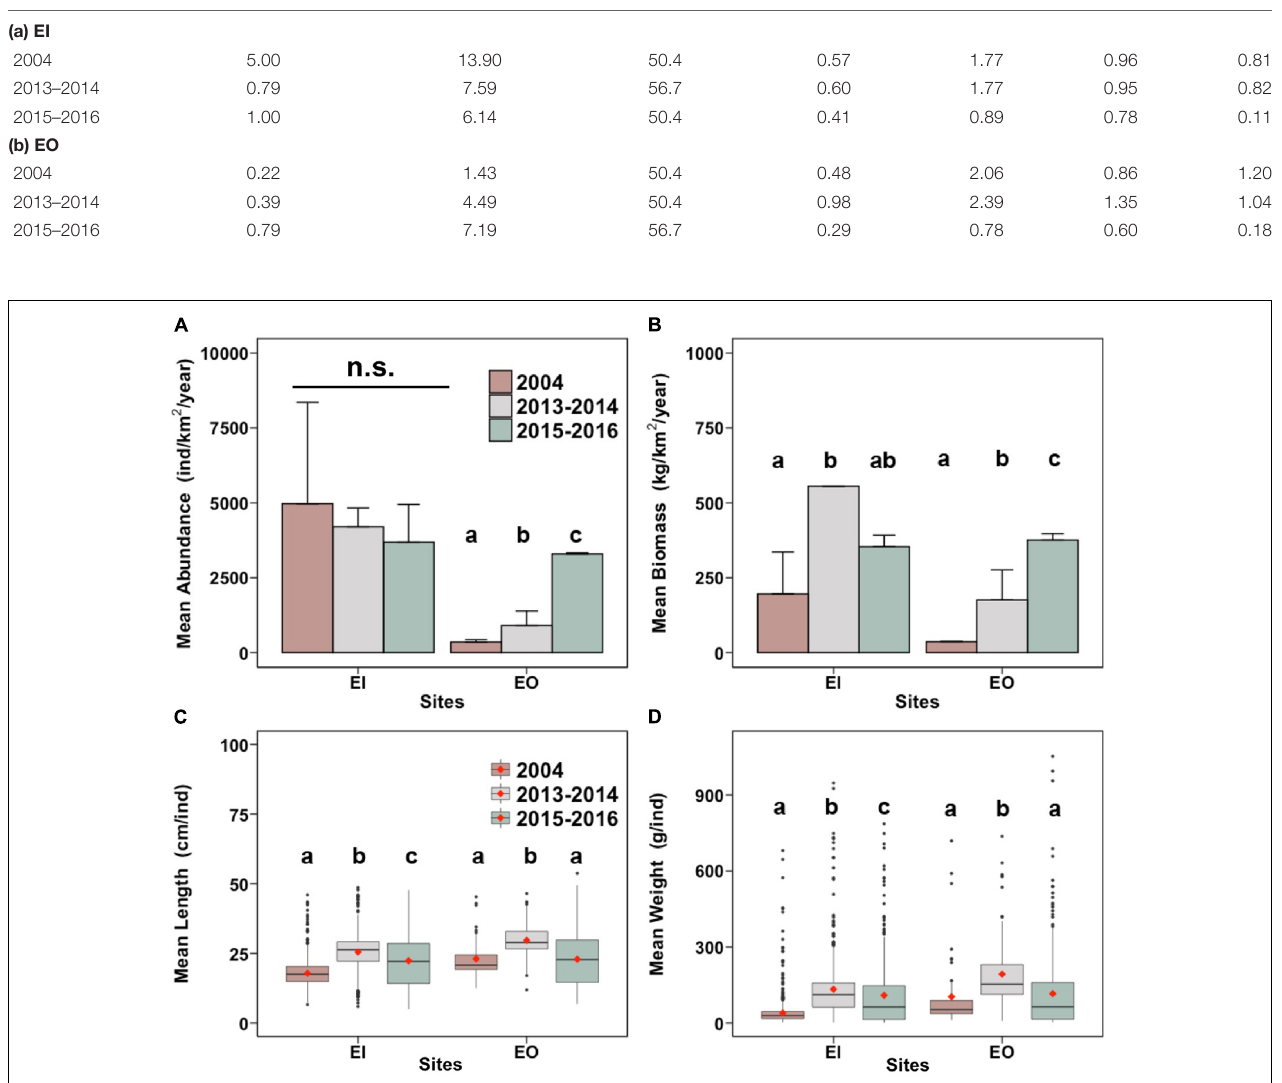
FIGURE 2 | Total annual abundance [ (A) ; mean + SEM; individuals/km 2 per year] and total annual biomass [ (B) ; mean + SEM; kg/km 2 per year], as well as mean length of individuals [ (C) ; cm/individual], and mean weight of individuals [ (D) ; g/individual] of Platycephalus indicus collected in inner Tolo Channel (EI) and outer Tolo (EO) of Hong Kong from January to December 2004 (before trawling ban), June 2013 to May 2014 (2013–2014; after trawling ban), and June 2015 to May 2016 (2015–2016; after trawling ban). In panels (C,D) , the vertical line shows the third quintile (Q) + 1.5 × interquartile range (IQR) to Q1 – 1.5 × IQR of the data. The black horizontal bars and red diamonds in the boxes indicate the medians and the means, respectively. In each panel and site, bars with different letters are significantly different ( p < 0.05); n.s. denotes no significant difference between the mean values among the 3